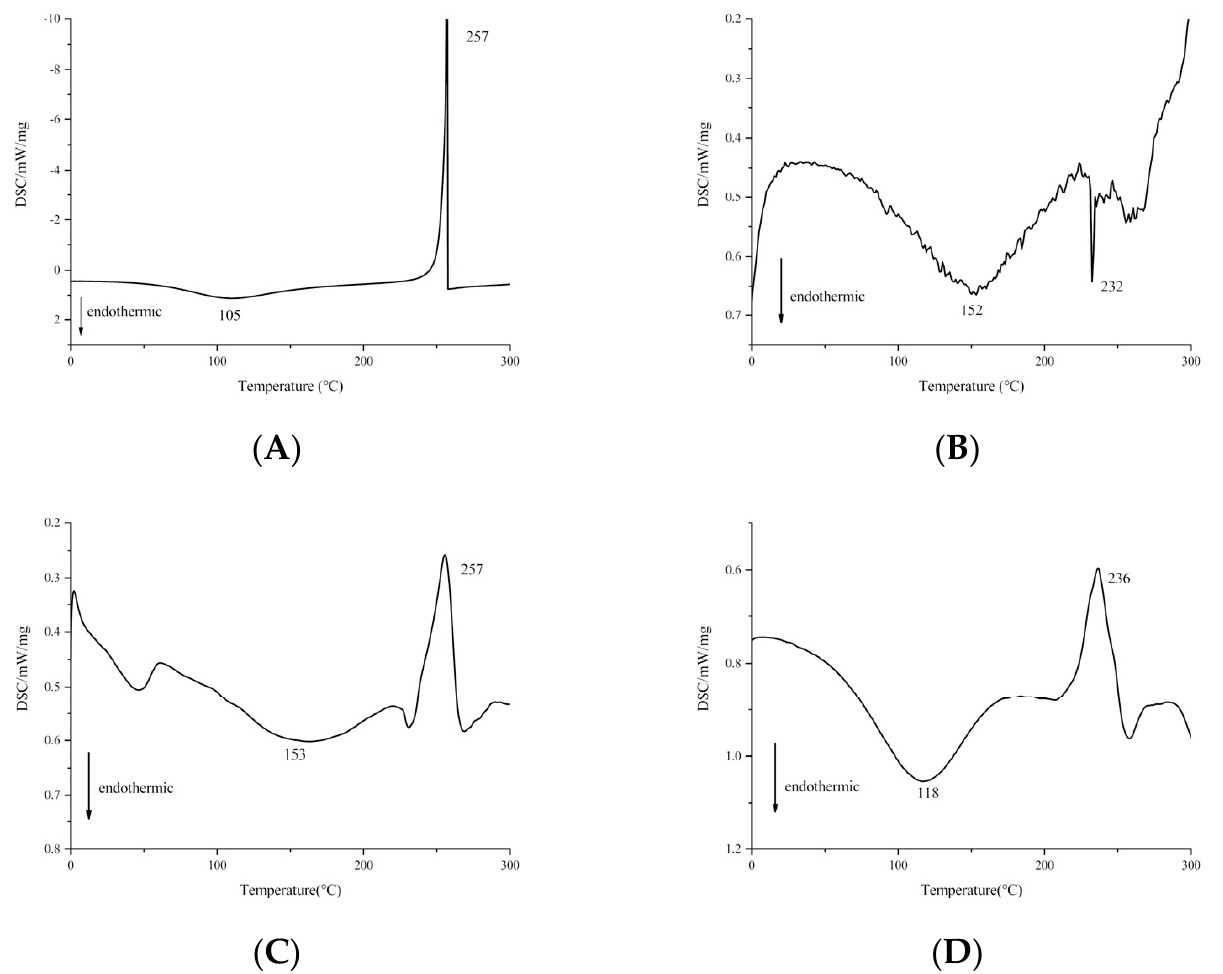
Figure 4. Differential scanning calorimetry (DSC) thermograms of ( A ) heparin, ( B ) phospholipids, ( C ) physical mixture of heparin and phospholipids, and ( D ) the HEP–Pc complex.